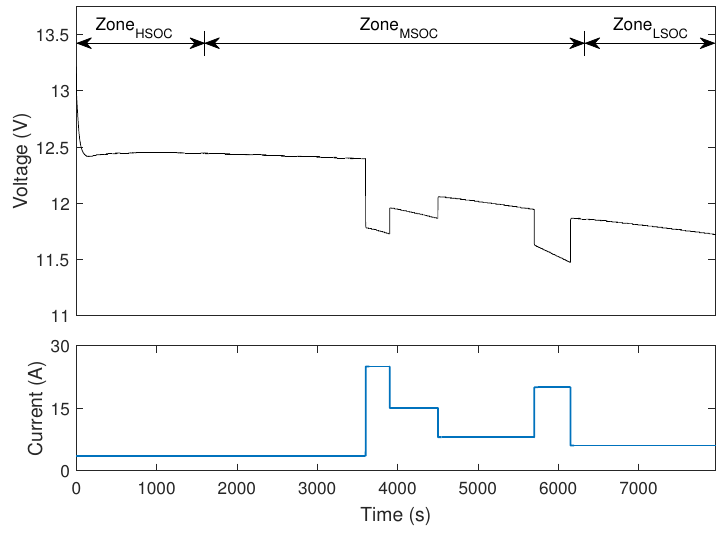
Figure 13. Experimental data from the validation test. The whole test took place in a DZ. Zone HSOC , Zone MSOC and Zone LSOC correspond to the zones with high, medium and low SOC,